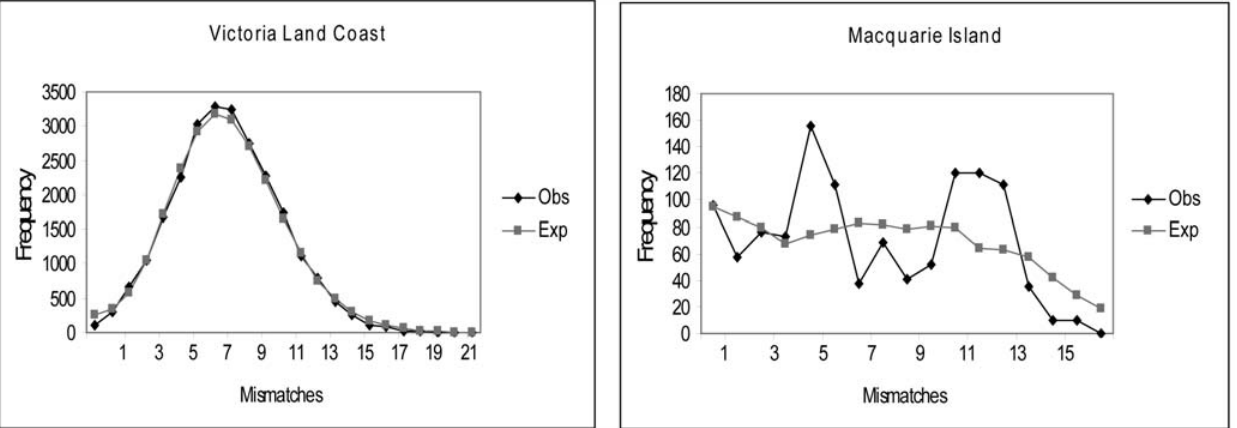
Figure 3. Mismatch distributions for mitochondrial DNA haplotypes sampled from the VLC and MQ populations. doi:10.1371/journal.pgen.1000554.g003 PLoS Genetics |